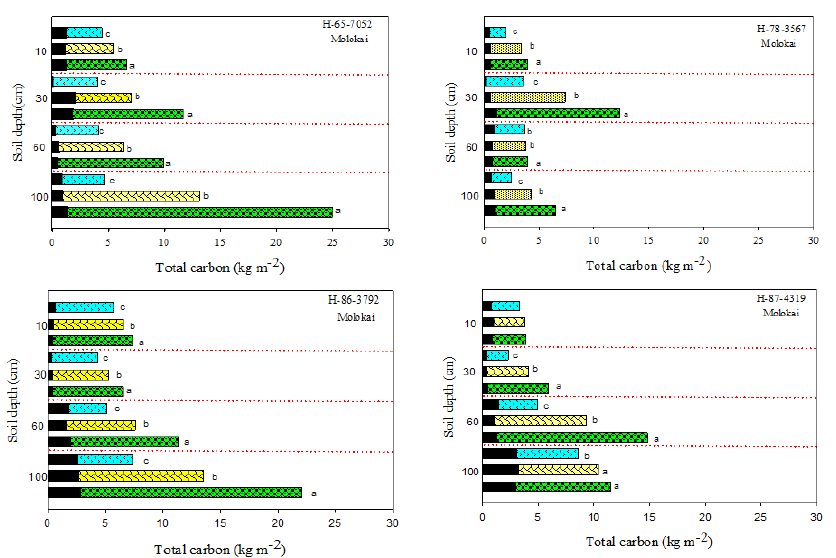
Figure 1. Total organic (OC) and inorganic (IC) carbon for the four sugarcane cultivars grown in Pulehu soils. Black (solid) portion of the bars represent the IC and color portion represent OC for each soil depth and sugarcane growing stages ( i.e. , blue (open arrows)-tillering, yellow (irregular shape)-grand growth, green (light circles)-maturity) when the soil samples were collected. Means followed by the same letter or no letters for the bars in each soil depth are not significantly different in the Tukey’s test at Pr < 0.05.